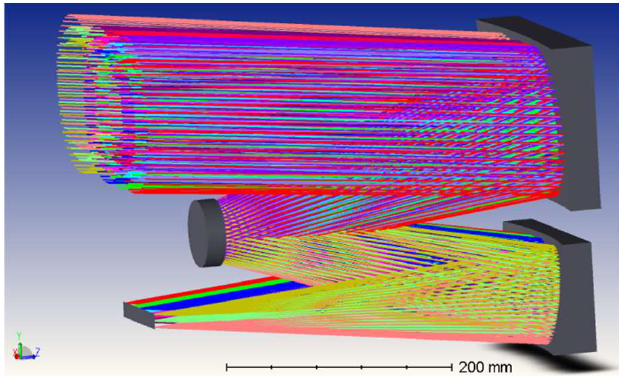
Figure 1. TMA optical system.